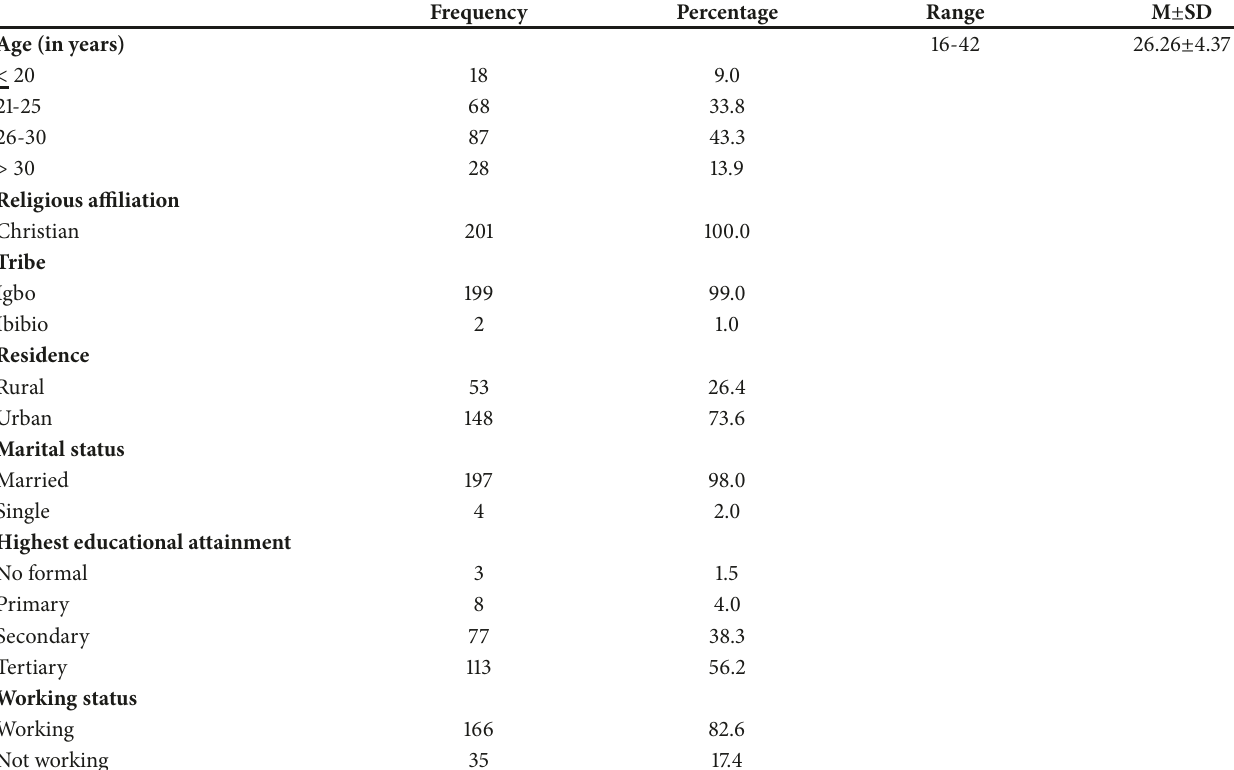
Table 1: Sociodemographic characteristics of the participants (n =